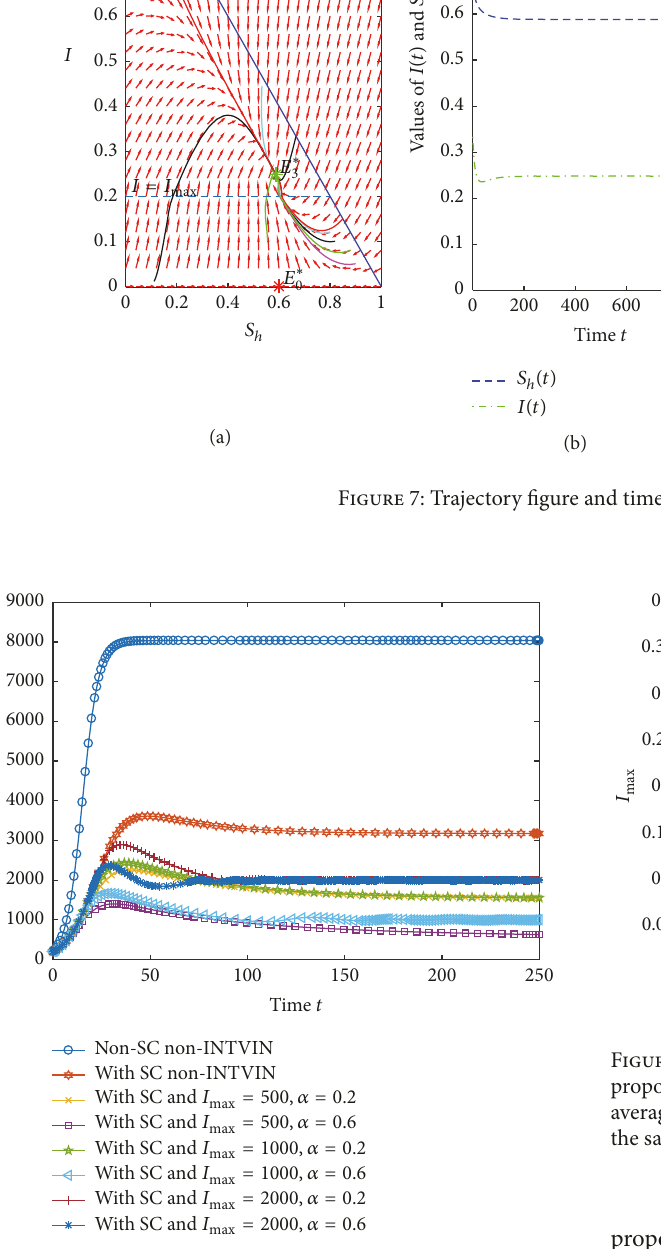
Figure 8: Time evolution of the infected nodes in different scenar- ios. model parameters are set as follows: 𝛽 𝑙 = 0.3, 𝛽 ℎ = 0.09, 𝛾 𝑙 = = 0.043, 𝑏 = 0.0012, 𝑏 = 0.0018, 𝜇 = 0.003 , 0.056, 𝛾 ℎ 𝑙 ℎ